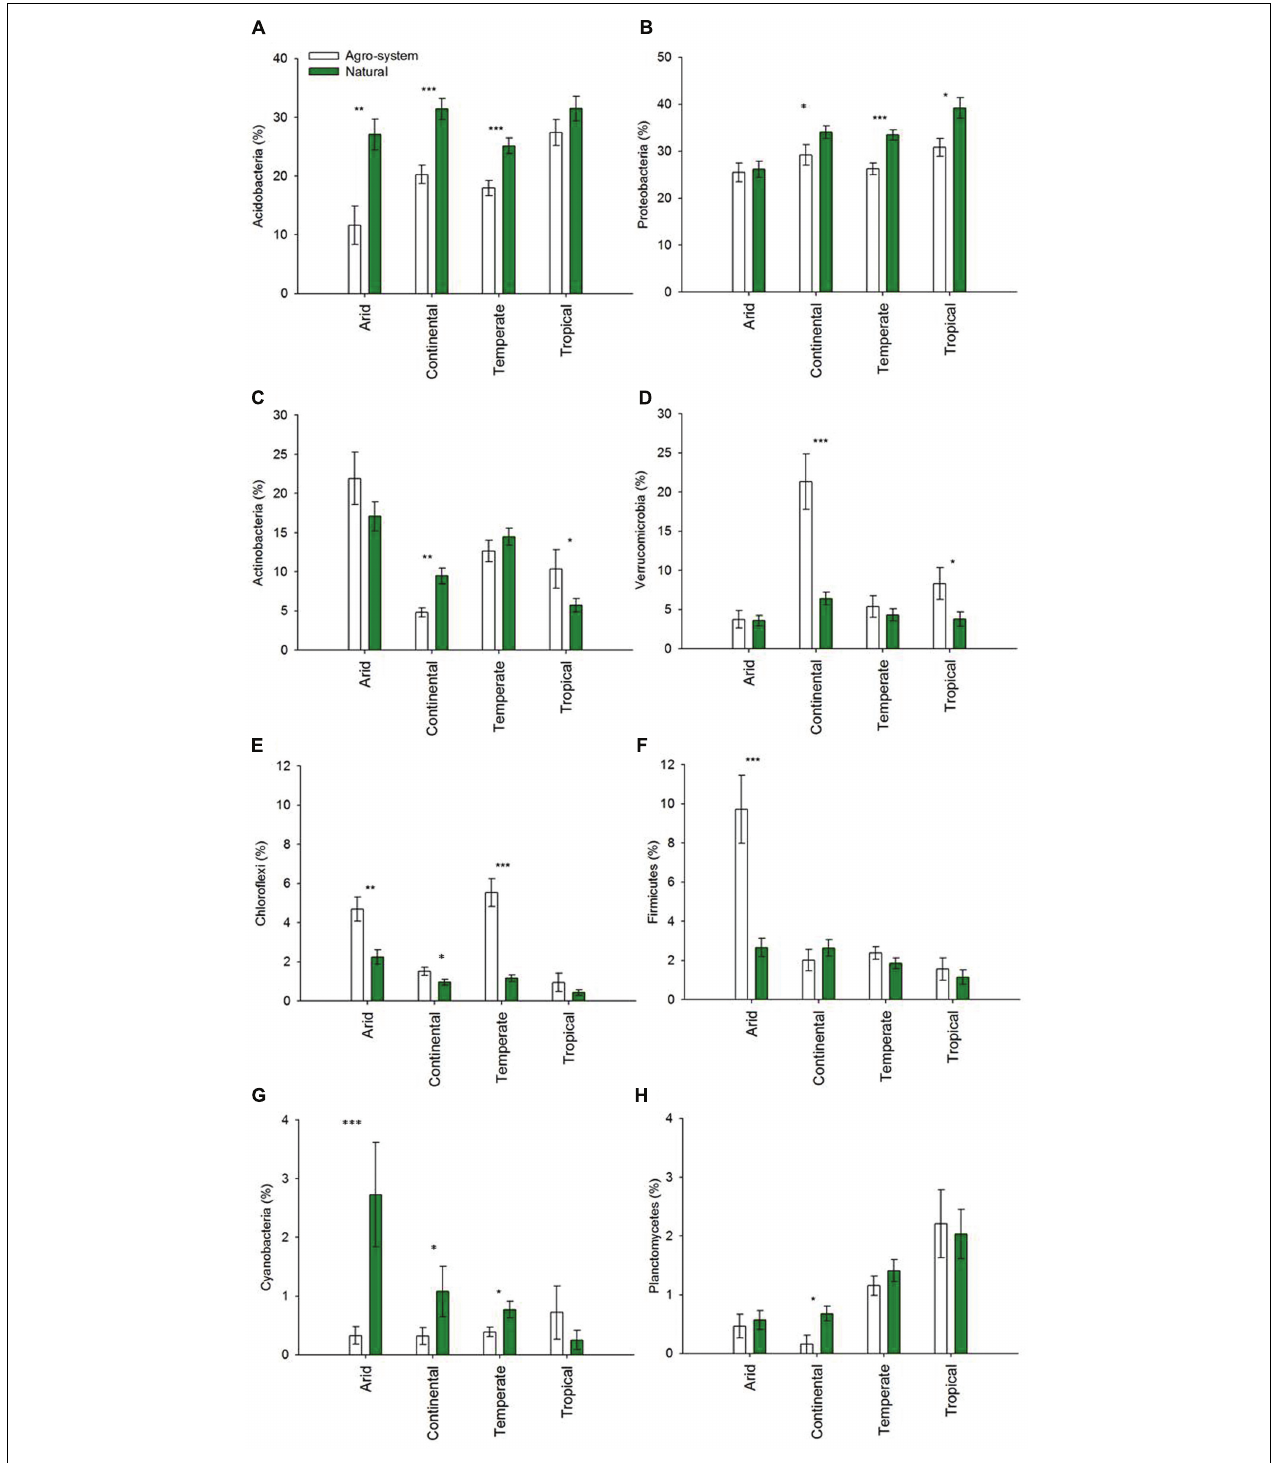
FIGURE 5 | Relative abundance of major bacterial phylum [(A) Acidobacteria ; (B) Proteobacteria ; (C) Actinobacteria ; (D) Verrucomicrobia ; (E) Chloroflexi ; (F) Firmicutes ; (G) Cyanobacteria ; and (H) Planctomycetes ] in agricultural vs. natural systems in different regions. The sites were selected based on a meta-analysis consisting of both published and unpublished data wherein bacterial diversity and compositions is described based on next generation sequencing techniques (either 454 or Miseq; see Material and Methods for more details). The main climate classes are based on global maps available for the most frequently used Köppen climate classification map (Kottek et al., 2006). ∗ P < 0.01; ∗∗ P < 0.001; ∗∗∗ P < 0.0001.